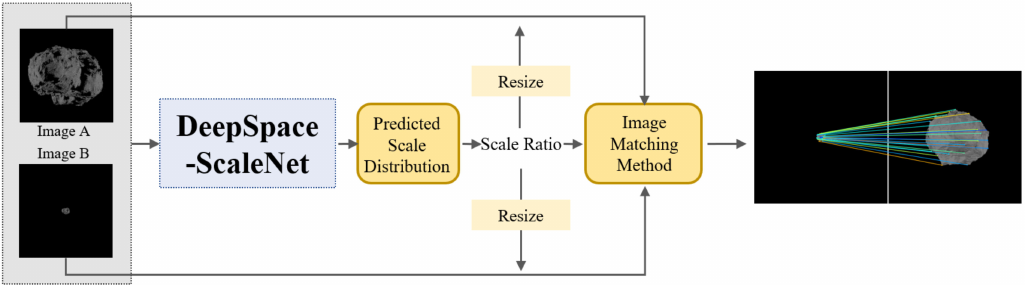
Figure 2. The Flowchart of Large-scale Invariant Method for SCB Image